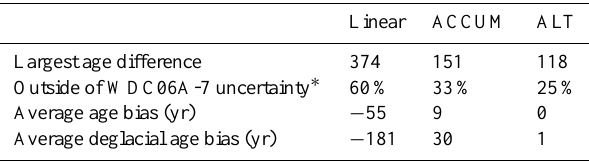
Table 2. Interpolation assessment for WDC06A-7.